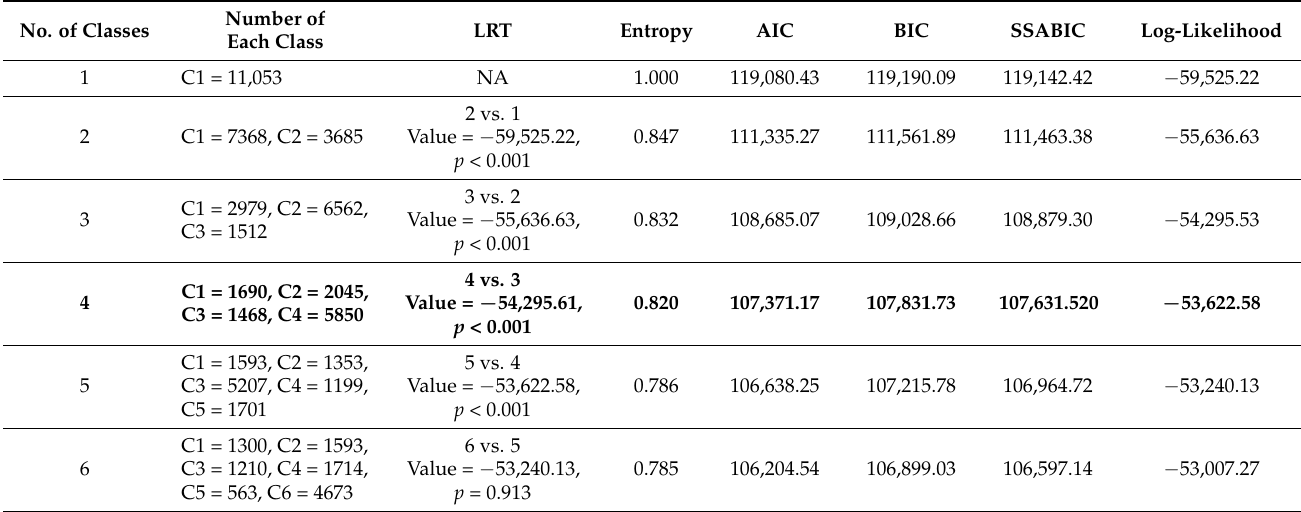
Table 1. Fit statistics for 1–6 latent classes ( N = 11,053).